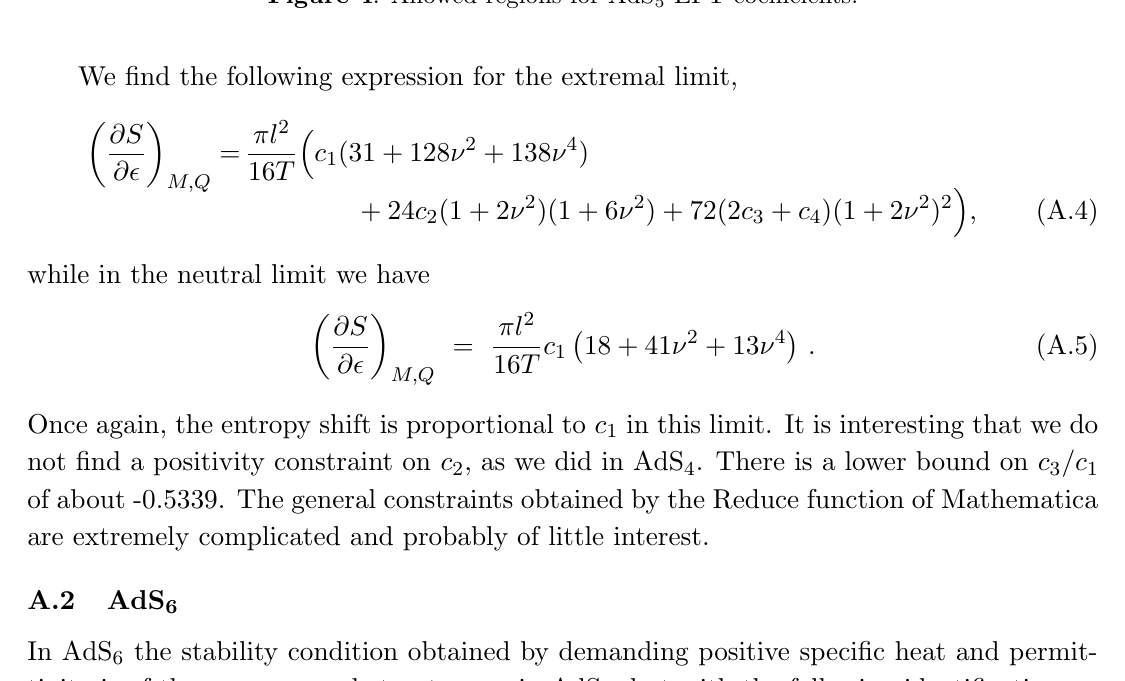
Figure 4 . Allowed regions for AdS 5 EFT